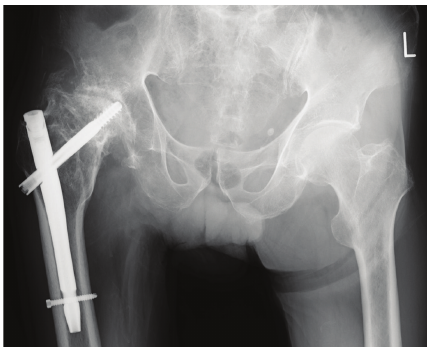
Figure 4: Anteroposterior radiograph captured 8 months after the operation showing strong bone union.